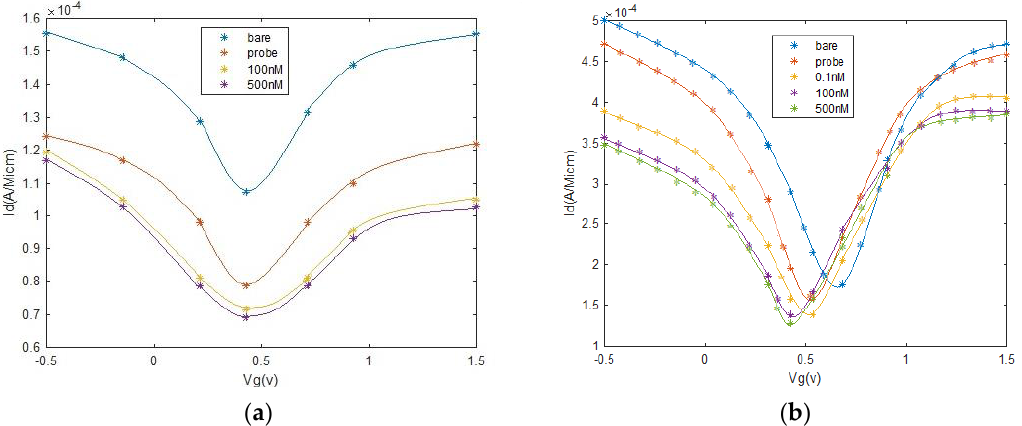
Figure 12. Transfer characteristics for GFET – based biosensor, bare, with the probe, and after DNA reaction, at different concentrations. ( a ) Mismatched ( b ) and complementary DNAs. Experimental data are shown in symbols, while solid lines show the GFET – based biosensor model fits by AVS.